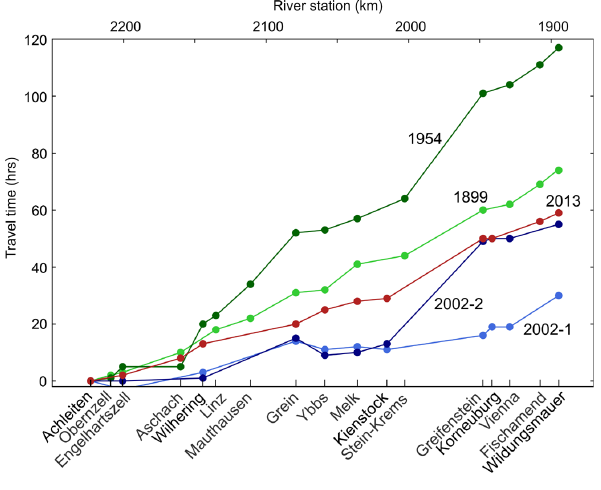
Fig. 10. Travel times of the 2013, 2002, 1954 and 1899 floods along the Austrian reach of the Danube from Achleiten near Pas- sau to Wildungsmauer near the Slovak–Austrian border. 2002-1 and 2002-2 relate to the first and second flood waves of the 2002 event, respectively. At Passau/Achleiten the flood peaks occurred on 3 June, 2013, 18:00; 8 August, 2002, 02:00; 13 August, 2002, 12:00; 10 July, 1954, 08:00; and 15 September 1899, 10:00, which has been plotted as 0 for the five floods in the figure.